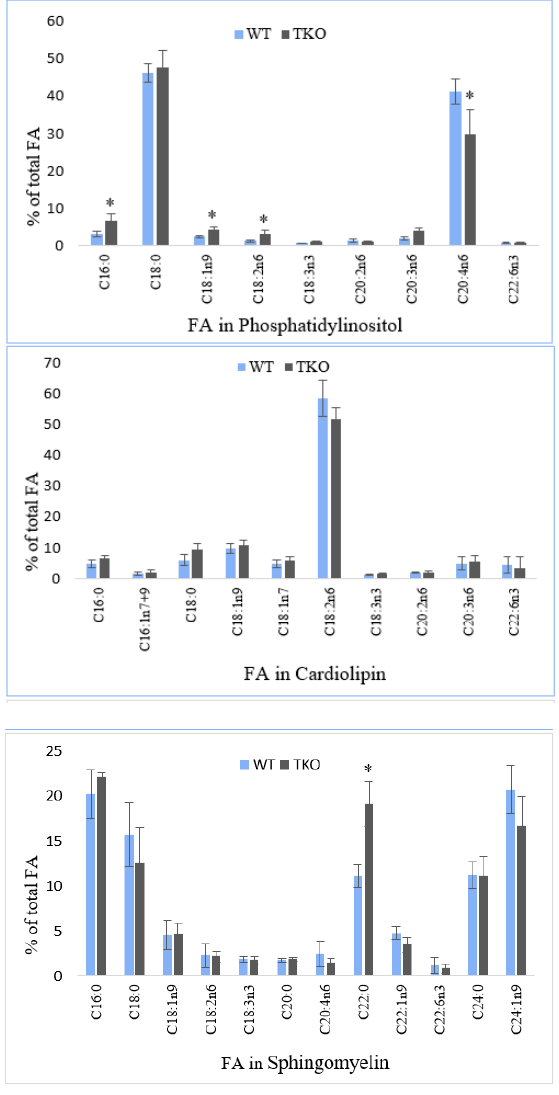
Figure 4. Fatty acid composition in individual polar lipid classes (% of total PL fatty acids) from the liver of wild-type (WT) and triple-synuclein null mutant (TKO) mice. Means ± s.d. ( n = 6) are shown. Fatty acids are indicated with the number before the colon showing the number of carbon atoms, the figure afterwards denoting the number of double bonds. The position of the first dou- ble bond is shown after “n”. Only the major fatty acids (≥0.5%) are present. The asterisk (*) indi- cates a significant effect of triple-synuclein deficiency when compared with WT ( p < 0.05). The analysis of FA in PC revealed six dominant FA, namely, palmitic, stearic, LA, ARA, oleic and DHA varying in their percentages from 18.9% (palmitate) to 8.8% (DHA) in PC from WT mice. Vaccenic, palmitoleic and ALA were found in low or trace amounts in PC of the liver. In synuclein-free mice, the level of ARA was significantly reduced from 14.5% to 8.9% with a reciprocal increase in the relative amounts of LA (from 15% to 18.6%); the reduced percentage of stearate was also noted in PC of the liver of TKO mice (Figure 4). The liver PE was dominated by the same FA as found in PC, although their relative